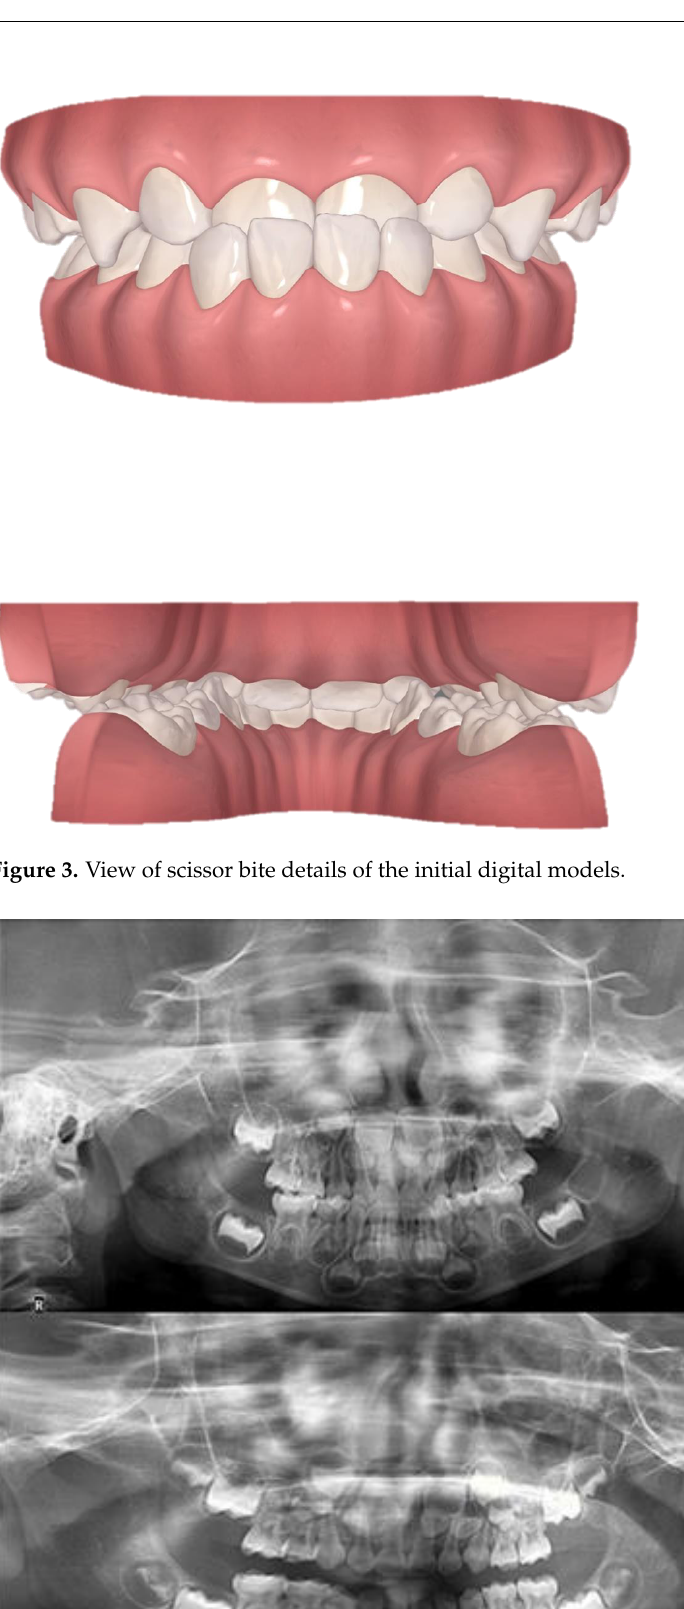
Figure 5. Measurement of adenoid thickness.